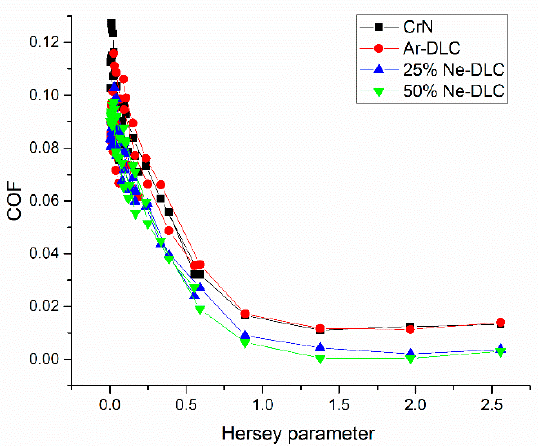
Figure 3. Stribeck curves for the lubricated contacts in the block-on-ring tests.